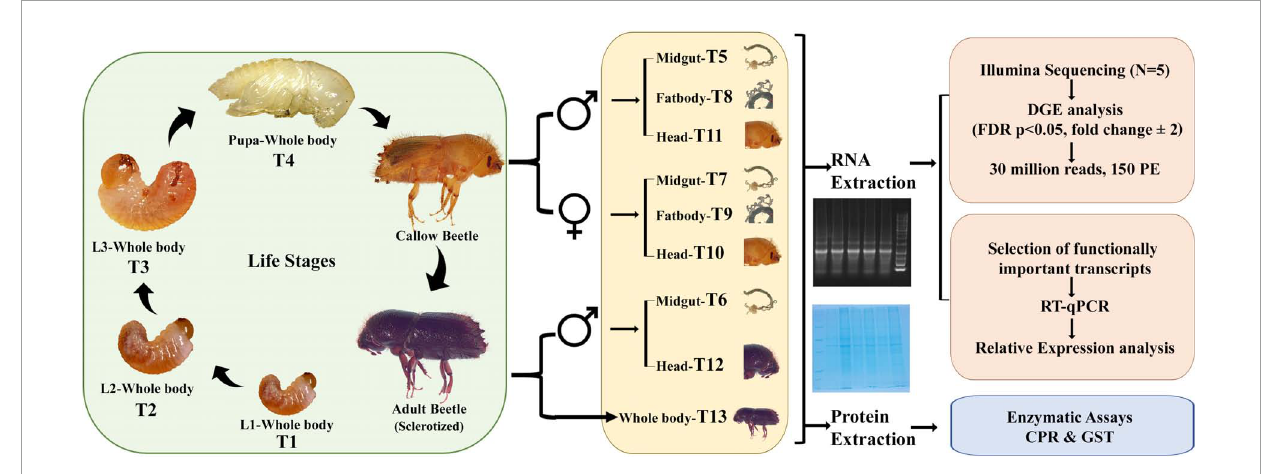
FIGURE1 Study design. Larvae 1 (L1/T1), Larvae 2 (L2/T2), Larvae 3 (L3/T3), Pupa (T4), Callow male gut (T5), Sclerotized adult gut (T6), Callow female gut (T7), Callow male fat body (T8), Callow female fat body (T9), Callow female head (T10), Callow male head (T11), Sclerotized adult male head (T12), Sclerotized adult whole body (T13) (CPR, Cytochrome P450; GST, Glutathione